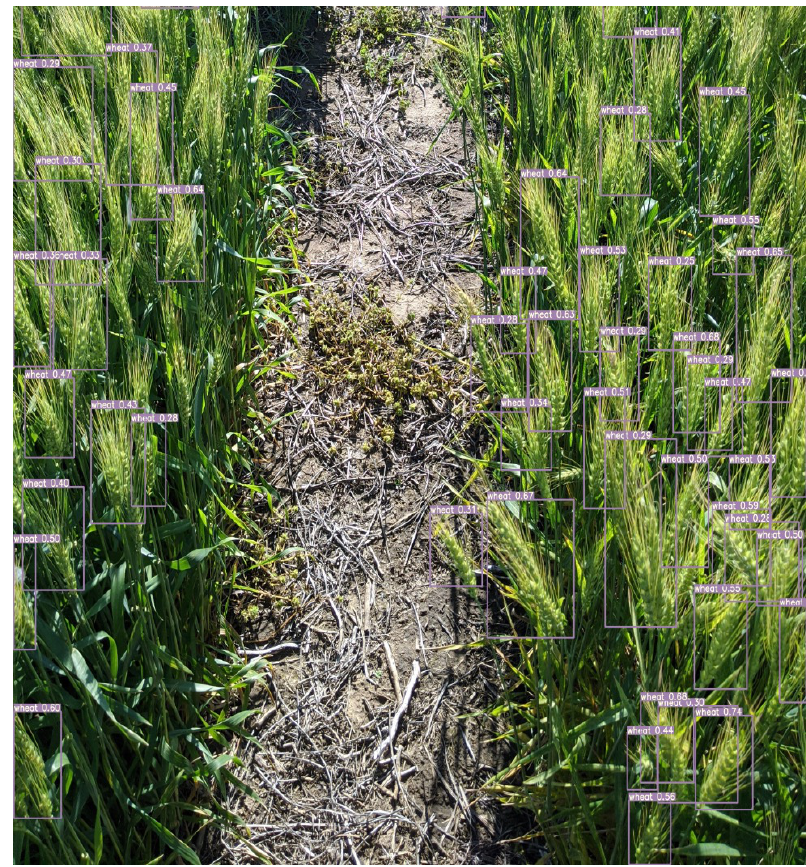
Figure 13. Real-time detection of wheat heads in the